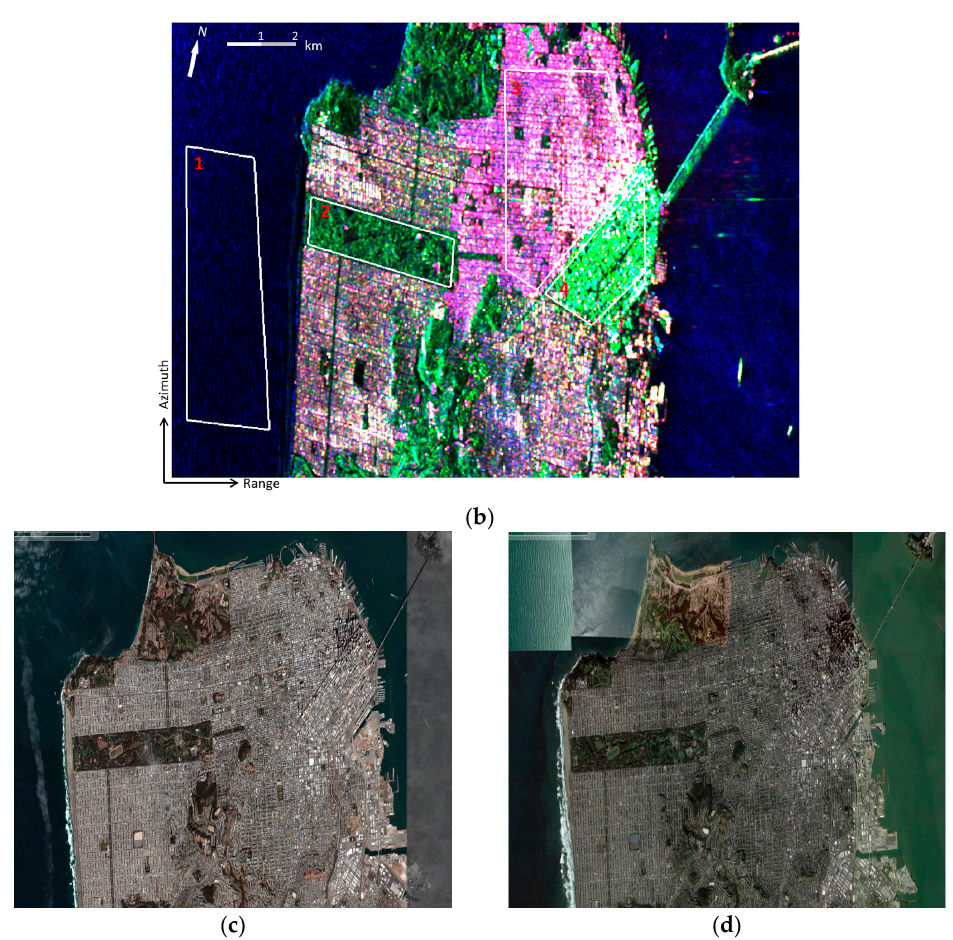
Figure 2. The Pauli-basis images of ( a ) GF-3 data collected on 15 September 2017, and ( b ) Radarsat-2 data collected on 9 April 2008. The outlined areas by white polygons are typical terrain types representing the ocean surface (1), forest (2), urban (3), and tilted urban (4) areas. ( c ) Google Earth image obtained on 25 September 2008, ( d ) Google Earth image obtained on 17 June 2017. We randomly selected 500 samples from each typical themes and Figure 4 gives the (cid:1834)/(cid:1853)(cid:1864)(cid:1868)ℎ(cid:1853) and the Δ(cid:2009) (cid:2886) /(cid:2009) (cid:2886) scatter plots. It is observed that by using the GF-3 data, samples from the ocean surface distributed more concentratedly than those of the Radarsat-2 data, and are more easily distinguished from the other theme pixels. This shows that the GF-3 data performs better in